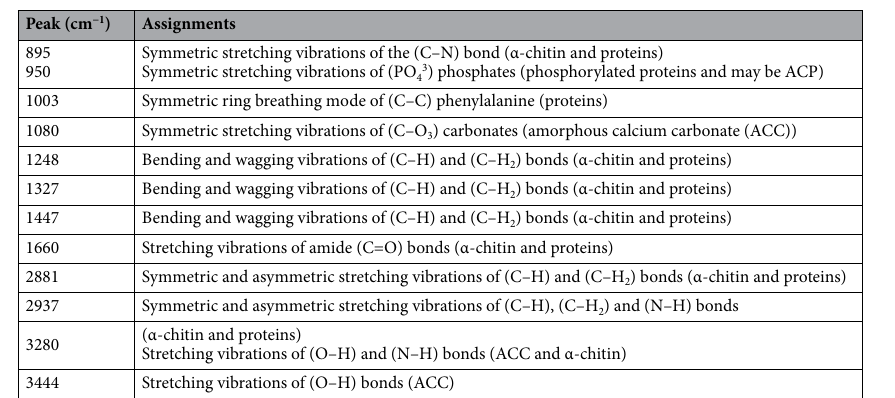
Table 1. Peak assignments corresponding to the chemical composition of the carapace of D. magna